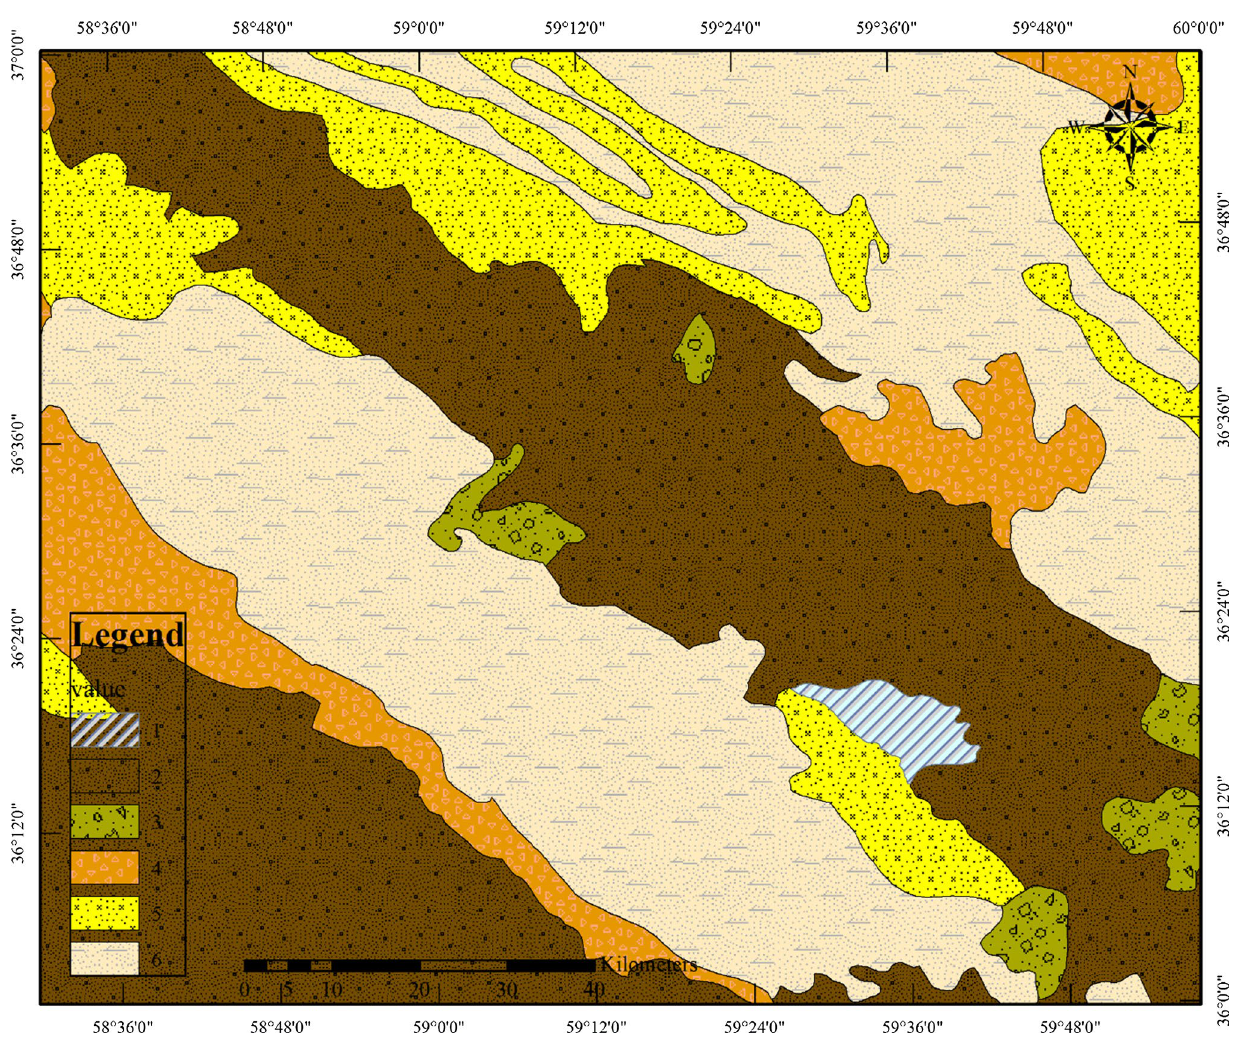
Fig. 6 Soil map and soil values Table 5 The preferential infiltration variable and scoring of this variable